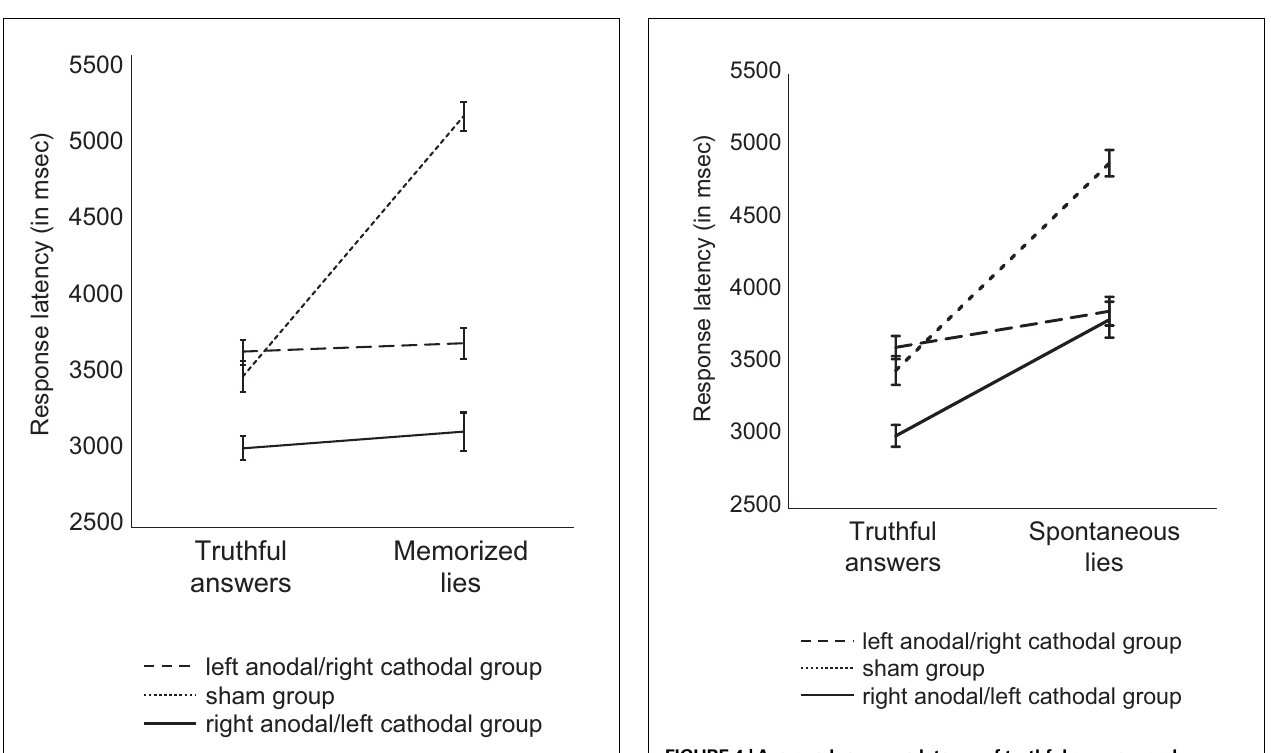
rect truthful answers at 92% (SEM = 0.7), 88% (SEM = 1.1), and 82% (SEM = 1.2), respectively, and correct memorized lies at 94% (SEM = 0.8), 91% (SEM = 1.0), and 91% (SEM = 1.1), respectively.